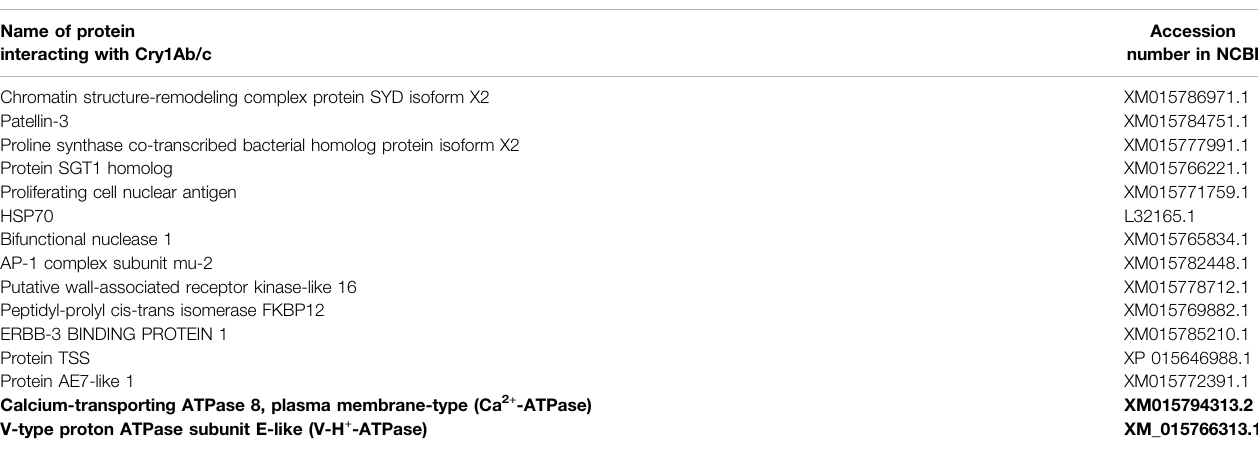
TABLE 1 | Detailed gene names and accession numbers of positive clones that interact with Cry1Ab/c protein. Name of protein interacting with